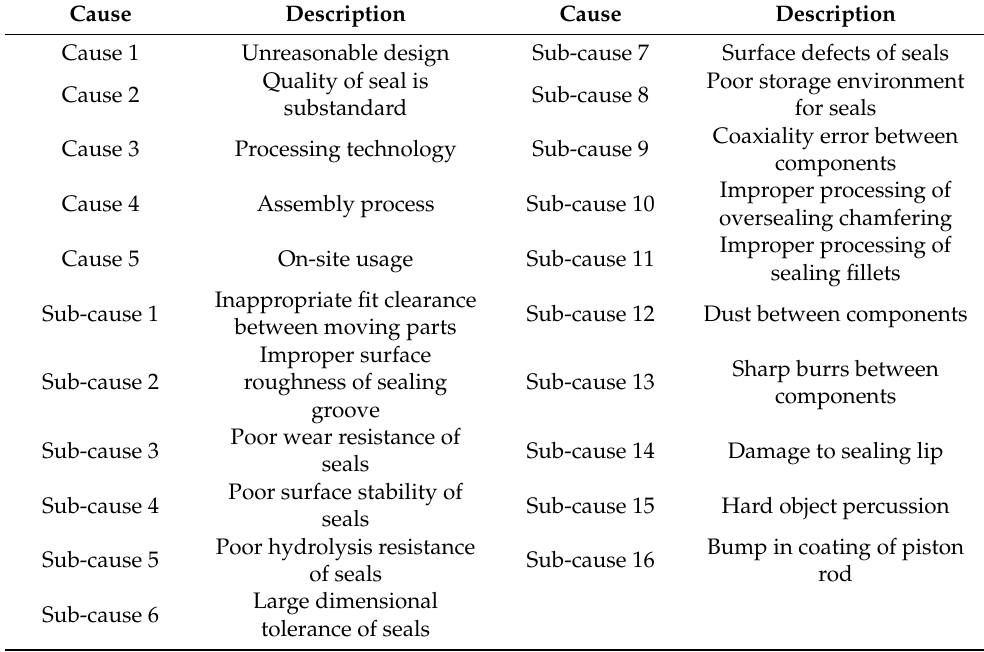
Table 5. Causes of jack leakage.